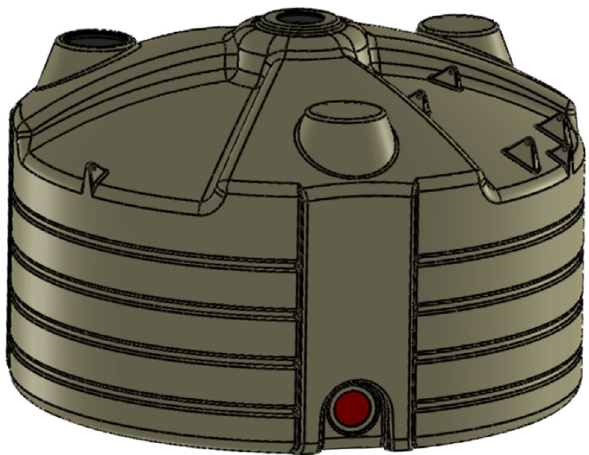
Fig. 10 Mercedes tank 3D external view